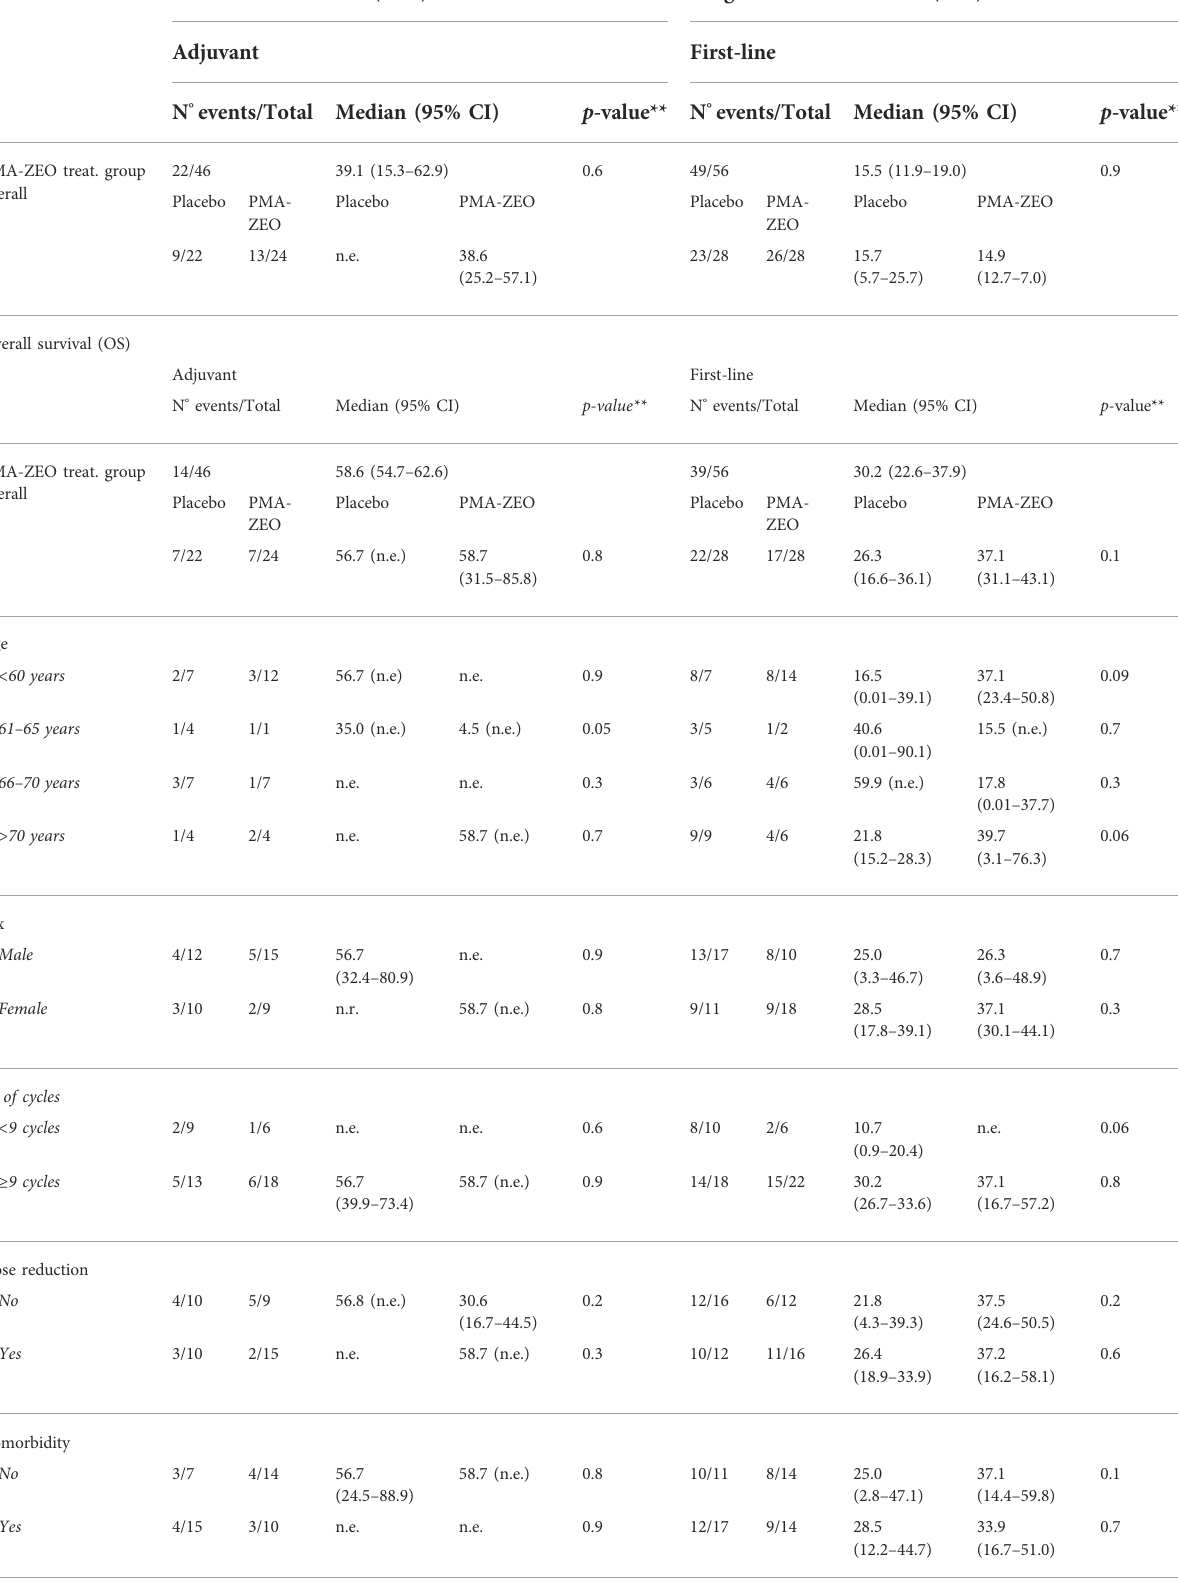
TABLE 2 Univariate analysis for DFS, PFS, and OS for the follow-up period of 30